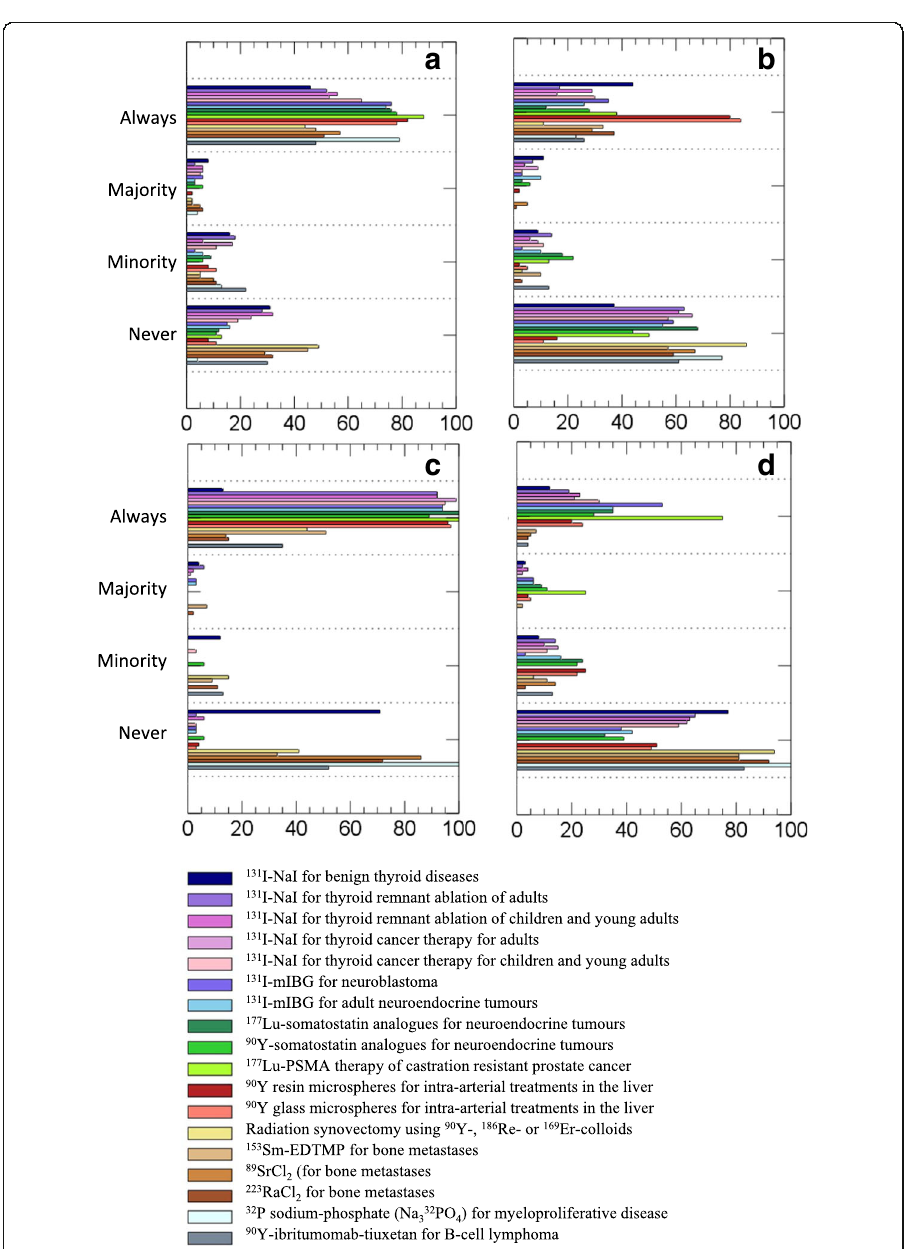
Fig. 2 Replies for the questions a “ Is a medical physicist involved in each treatment? ” , b “ Is the absorbed dose individually planned for each patient? ” , c “ Is post-therapy imaging performed? ” , and d “ Is post-therapy dosimetry performed? ” . Numbers on the horizontal axis represent the percentage of the total number of responses for a particular therapy that gave the indicated obtained for therapies with a limited geographical spread ( 177 Lu-PSMA: 2 countries; 90 Y PPRT: 6 countries; and 32 P sodium-phosphate: 4 countries).